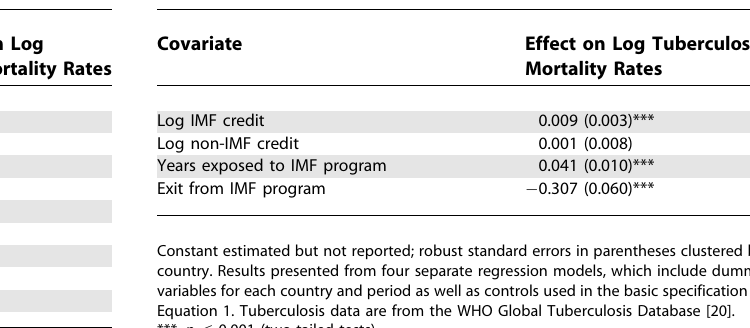
Table 3. Associations of IMF Lending Programs with Log Tuberculosis Mortality Rates